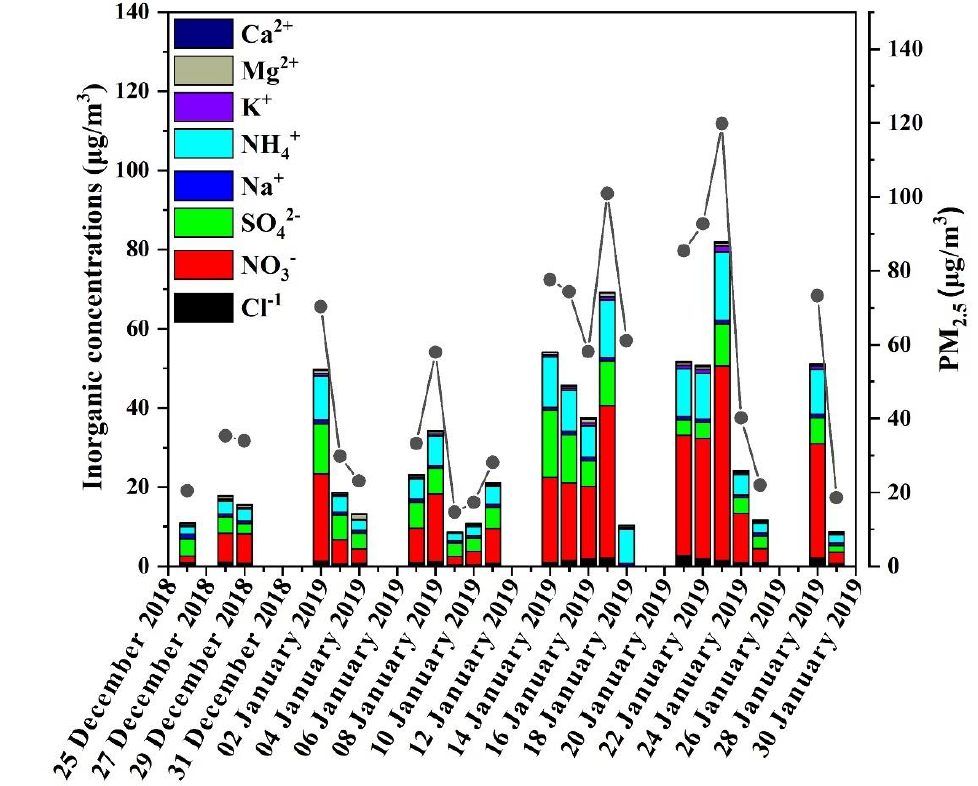
Figure 2. Trend of ion concentrations during winter sampling in Shanghai.